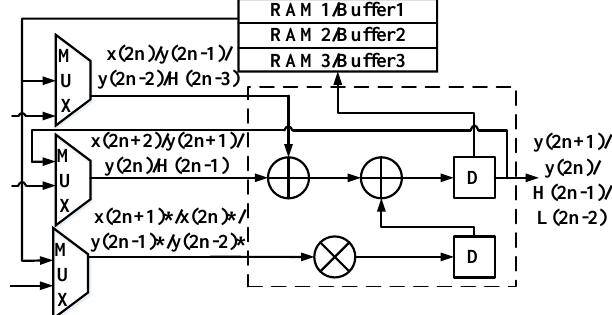
Figure 7. The 1-D DWT structure for the third level. Note: The items with * are the multiplication terms that should arrive ahead of